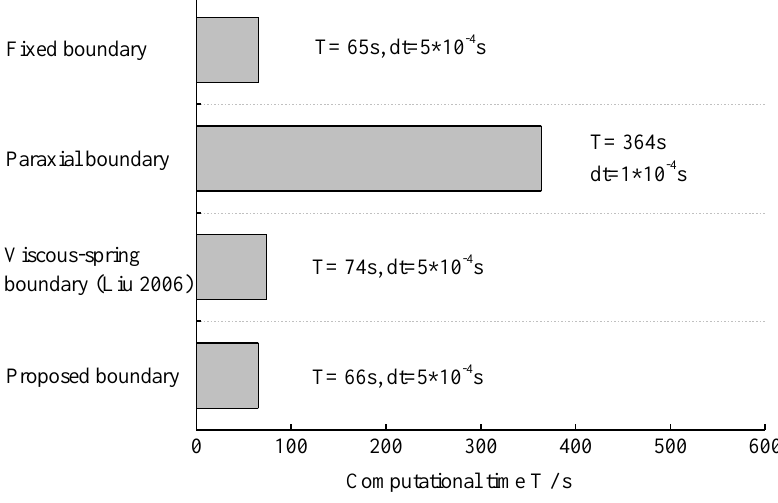
Figure 6. Comparison of computational time [51].